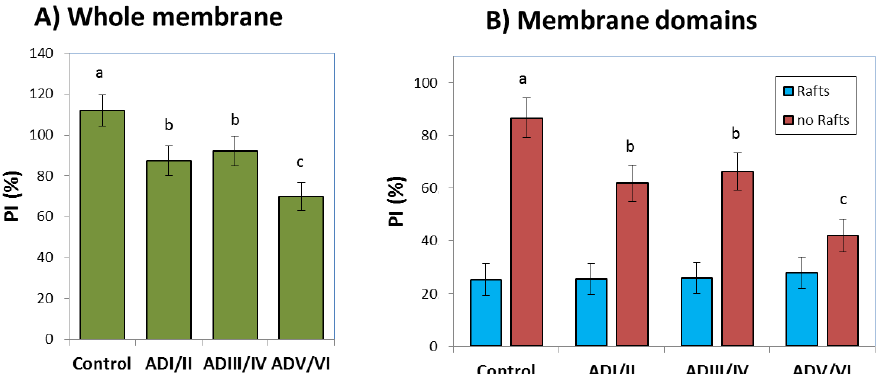
Figure 6. ( A ). Cumulative peroxidability index (PI) in the membrane patches shown in Figure 5. ( B ). Domain peroxidability indexes inside and outside lipid rafts (non-rafts) in the membrane patches shown in Figure 5. Results are expressed as the mean ± SD. Different letters on bars indicate statis- tically significant differences between groups with p < 0.05.